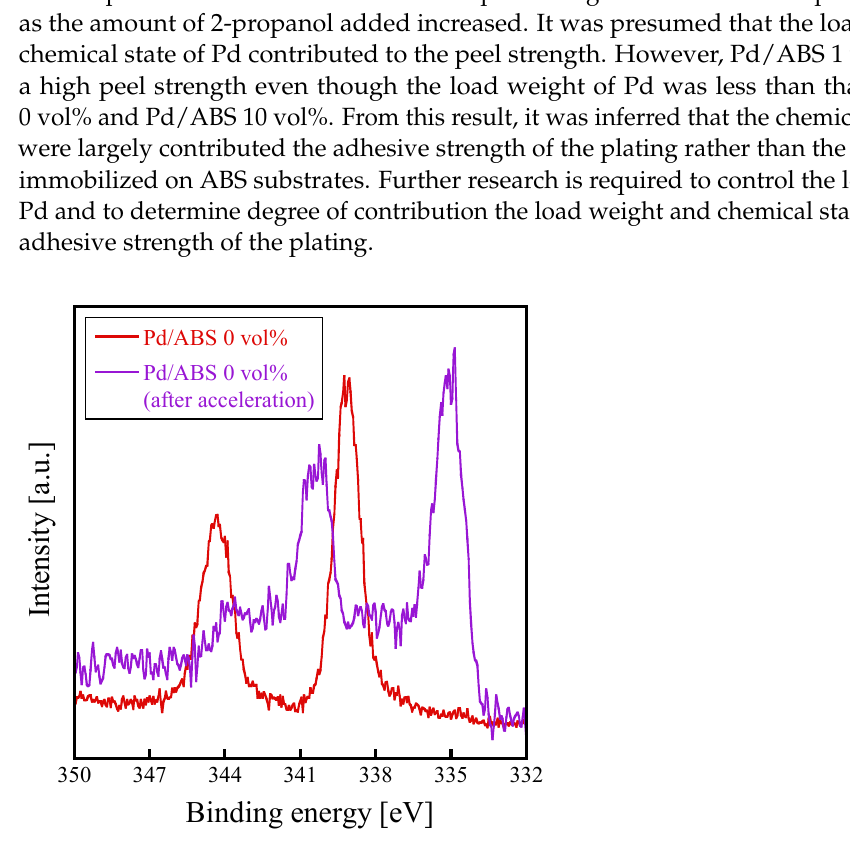
Figure 5. Pd3 d -XPS spectra of Pd/ABS 0 vol% before and after the acceleration step. The XPS spectrum before the acceleration step (red line) is normalized to a peak intensity of 339.2 eV. The XPS spectrum after the acceleration step (purple line) is normalized to a peak intensity of 335.2 eV.